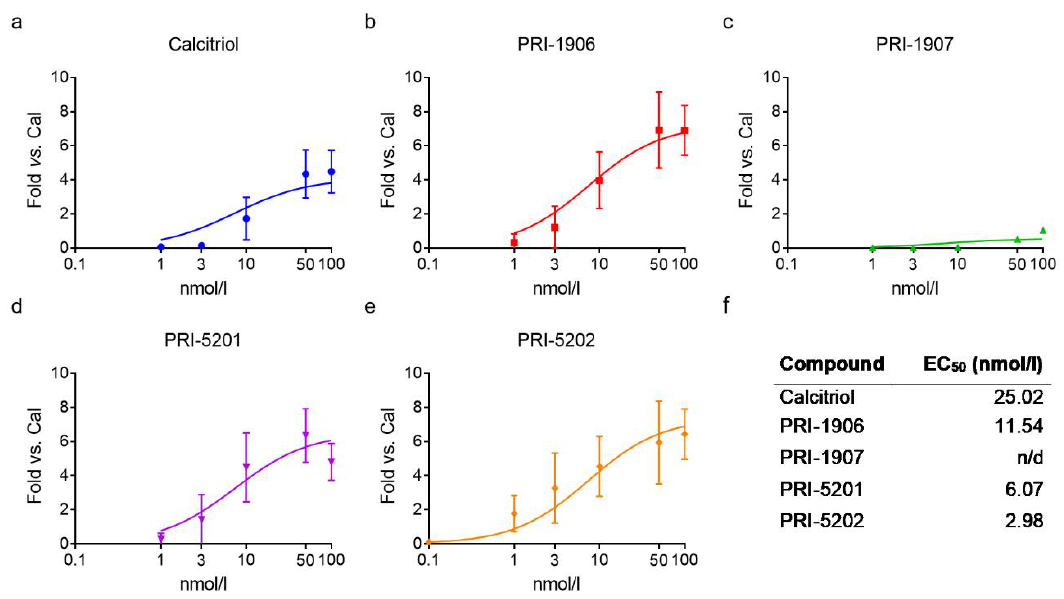
Figure 3. Activity of the compounds in the 13781 cell line. ( a – e ) Concentration-response curves of CYP24A1 expression after treatment with the an1,25Ds for 4 h. Mean ± SD, nonlinear regression: sigmoidal three parameter fit with the following constraints: bottom > 0, EC 50 > 0; N = 3–8. ( f ) The table shows the calculated EC 50 values (n/d = not determined).